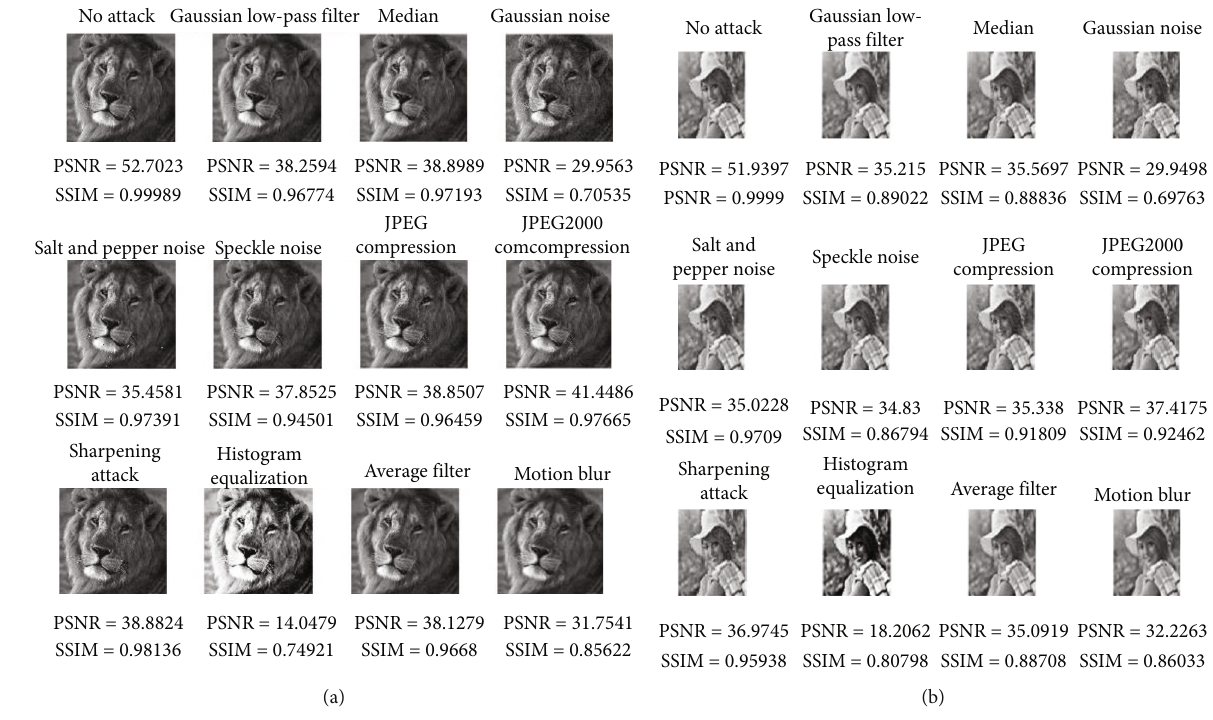
Figure 9: Performance of proposed system to extract attacks from watermarked images with respect to invisibility: (a) lion image and (b) Elaine image.